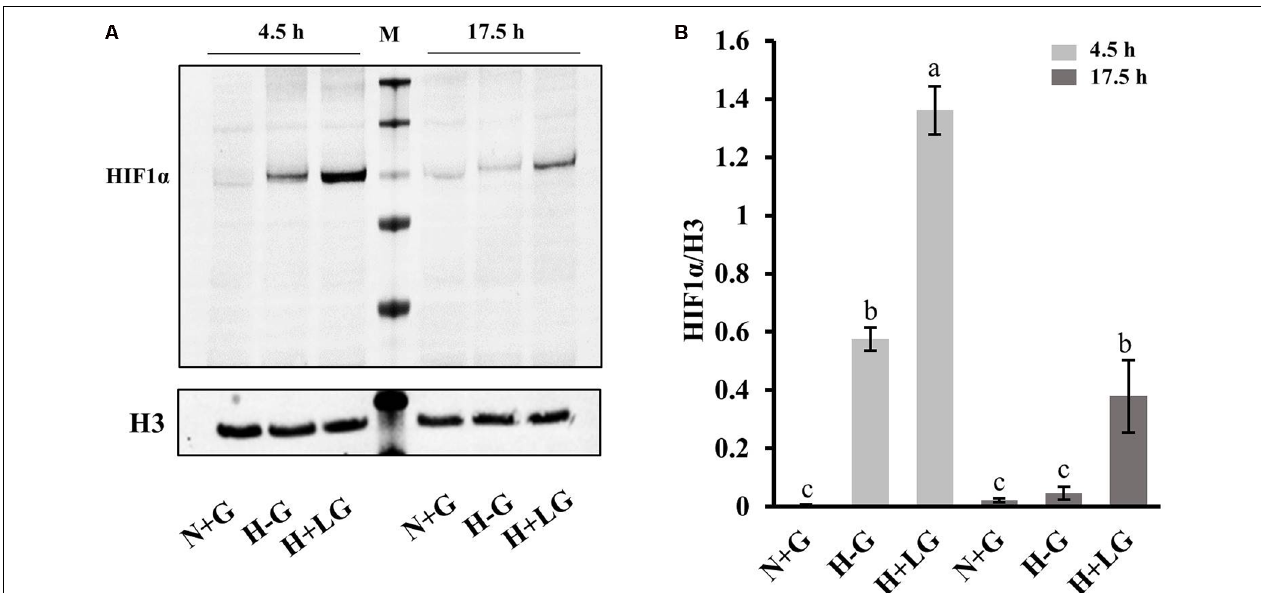
FIGURE 9 | Western blot analysis of HIF1 α . (A) Representative Western blotting of nuclear proteins isolated from cells treated with N+G, H − G, or H+LG conditions for 4.5 or 17.5 h against anti-HIF1 α and control anti-histone 3 (H3). (B) The ratio of band intensity between HIF1 α and H3 was calculated. All data plotted are the average of three independent experiments ± SD. One-way ANOVA followed by Fisher’s least significant difference for multiple comparisons was used for statistical analysis. Different letters labeled represent significant differences at p < 0.05 level among